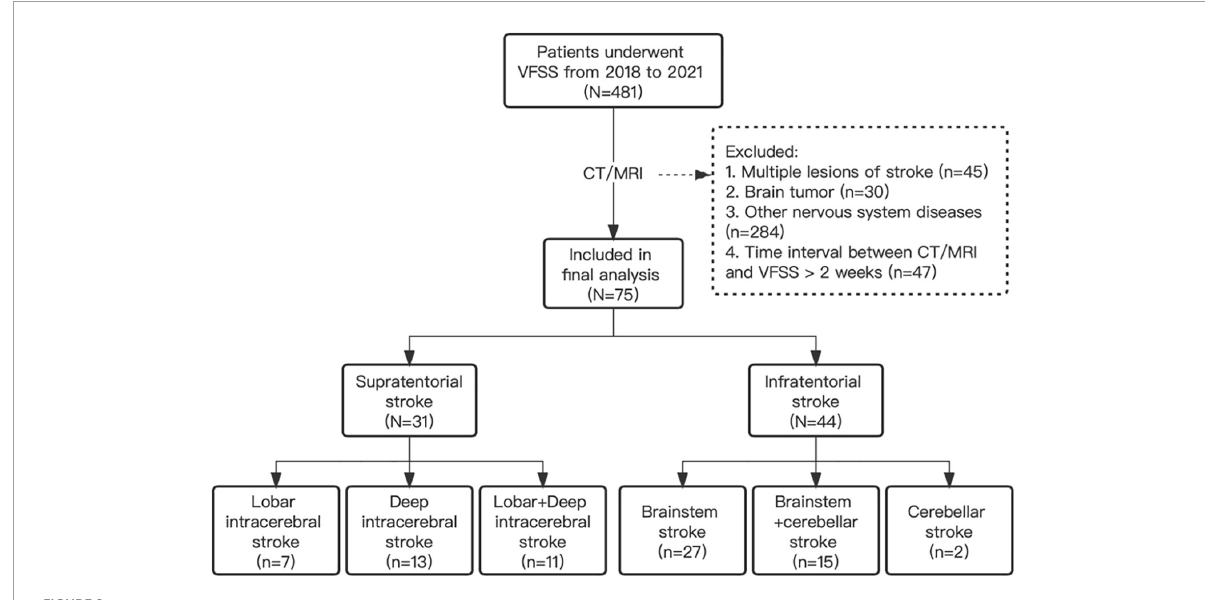
FIGURE2 The flow diagram of the study design. VFSS, videofluoroscopic swallowing study.